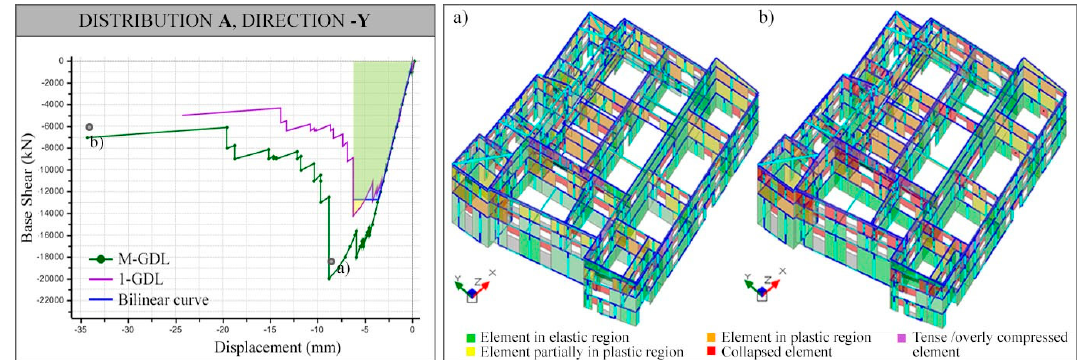
Figure 18. ( Left ): capacity curves from the pushover analysis with a triangular force distribution A negative Y direction; ( Right ): shear status of the masonry walls at the step corresponding to ( a ) the ultimate limit state (ULS) and ( b ) the last step of the analysis.